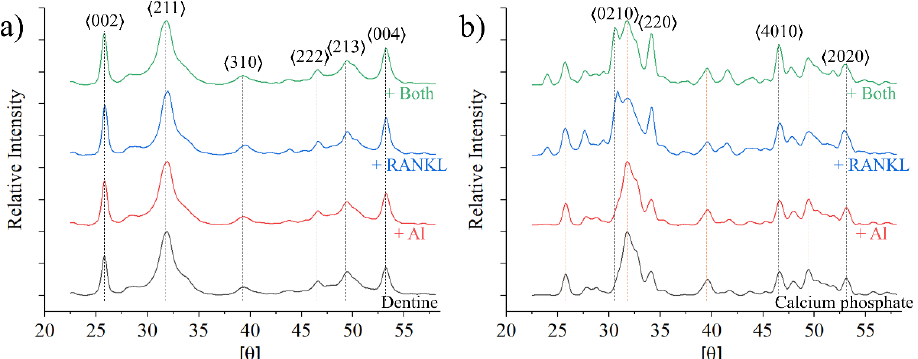
Figure 6. X-ray diffraction patterns for the two different materials, at different conditions. ( a ) Den- tine and ( b ) octacalcium phosphate. Peaks related to hydroxyapatite are marked in ( a ), while only the peaks related to octacalcium phosphate are marked in ( b ).